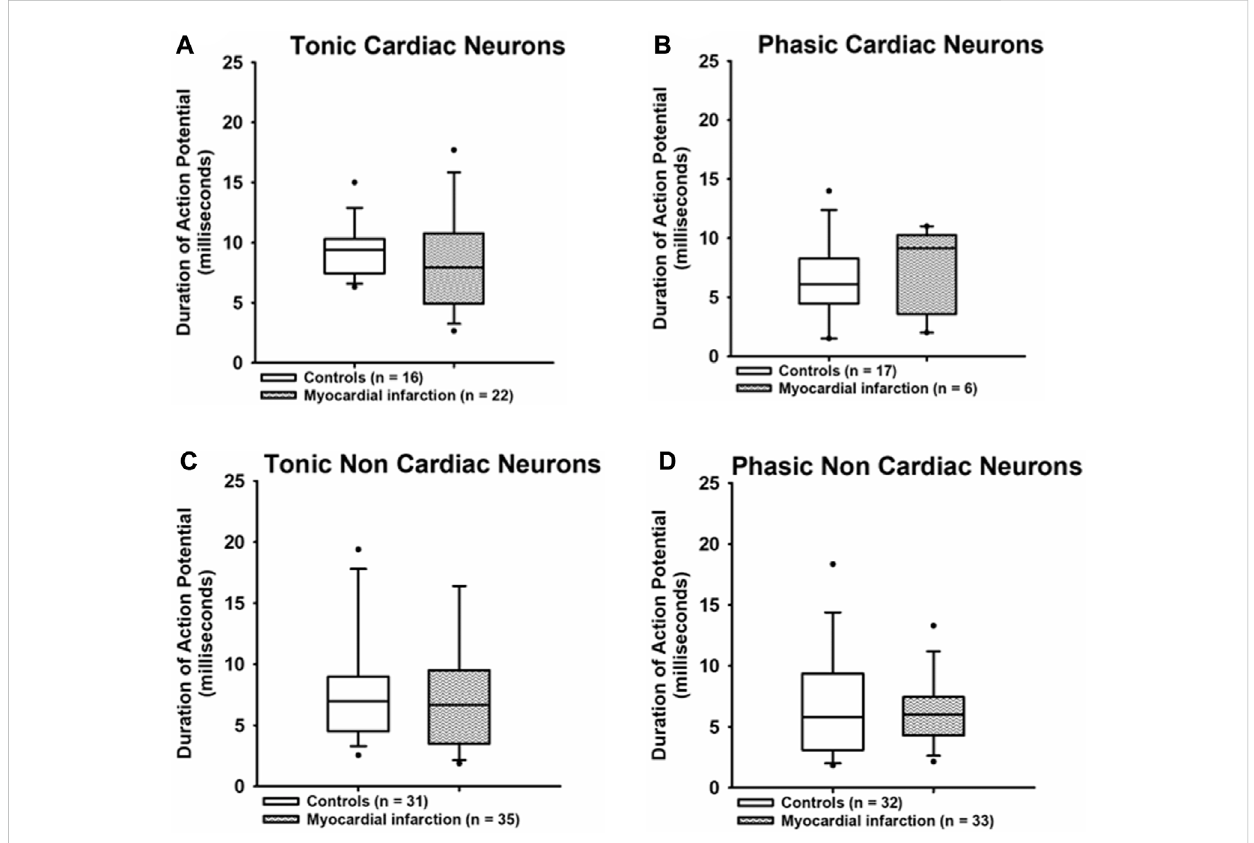
FIGURE 5 Myocardial infarction didnot affect theduration ofaction potentials. The durations (ms) ofaction potentials measured atthethresholdpotentialare presented. The duration of action potentials due to current injection in all groups of neurons [upper panels (A,B) : cardiac; lower panels (C,D) : non- cardiac]wereagainnotsigni fi cantlydifferentamongthevariousgroupsofneurons.Shownarethemedians,the25th/75th(boxboundaries)andthe10th/ 90th percentiles (black dots). Kruskal – Wallis one-way ANOVA on ranks was used with Dunn ’ s post - hoc method. Neurons were investigated in the voltage clamp mode of patch clamp